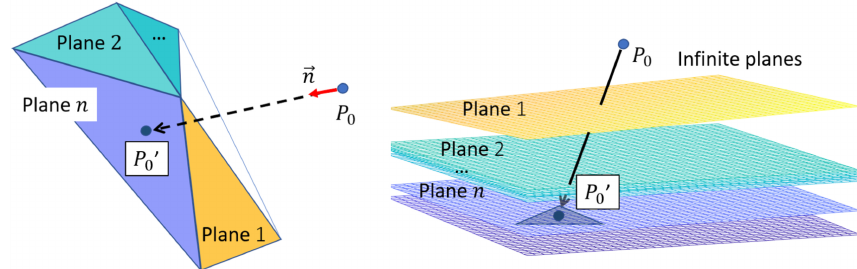
Figure 6. Infinite planes of each triangle are crossed by the projected